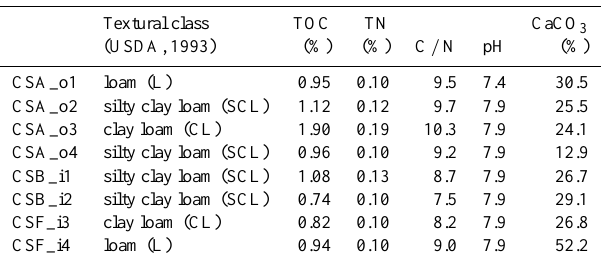
Table 2. Soil physical and chemical parameters of the investigated vineyard sites (March